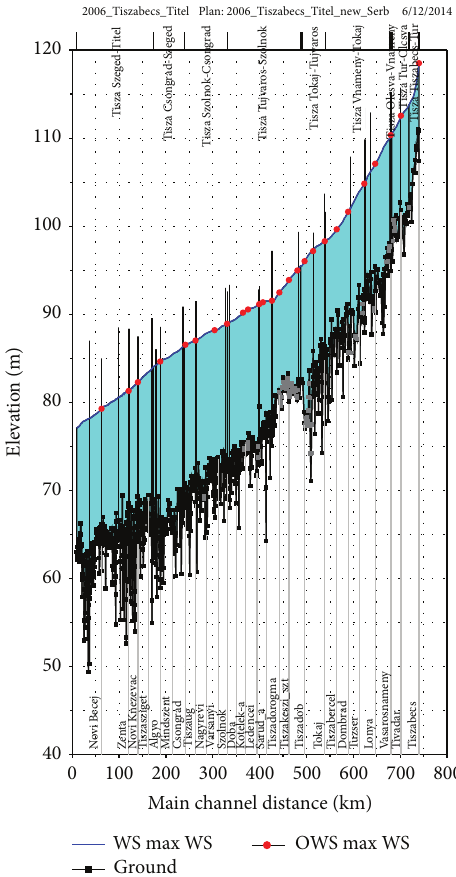
Figure 4: Verification of the calibrated parameters against the observed water levels of the 2006 flood.